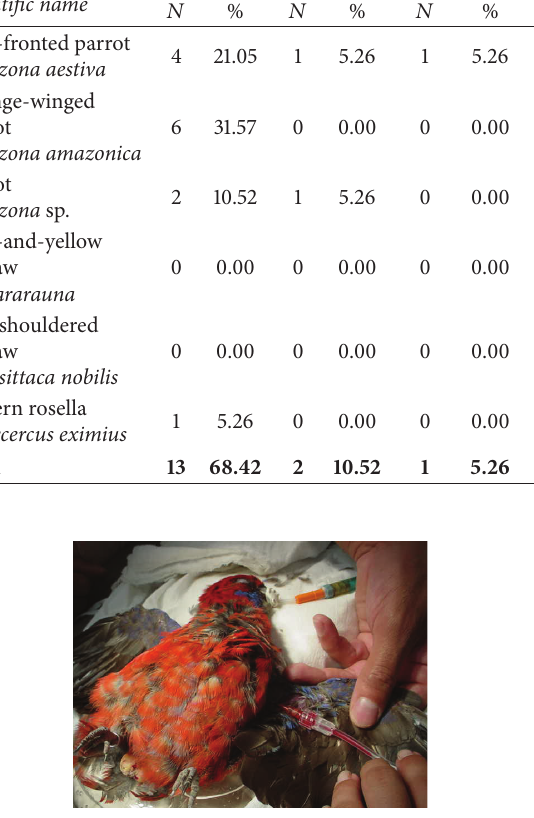
Figure 2: Case number 16: eastern rosella ( Platycercus eximius ) undergoing preoperative procedures. Note the endotracheal tube (adapted urinary catheter) in place and the catheterization of the brachial vein for intraoperative fluid therapy.